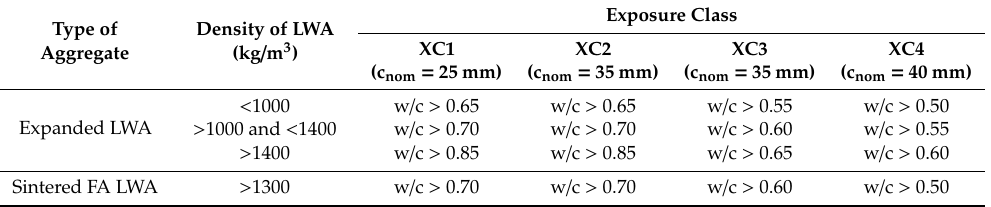
Table 4. Minimum w / c for SLWAC with intended design service life of 50 years under carbonation- induced corrosion, proposed by [101] *.